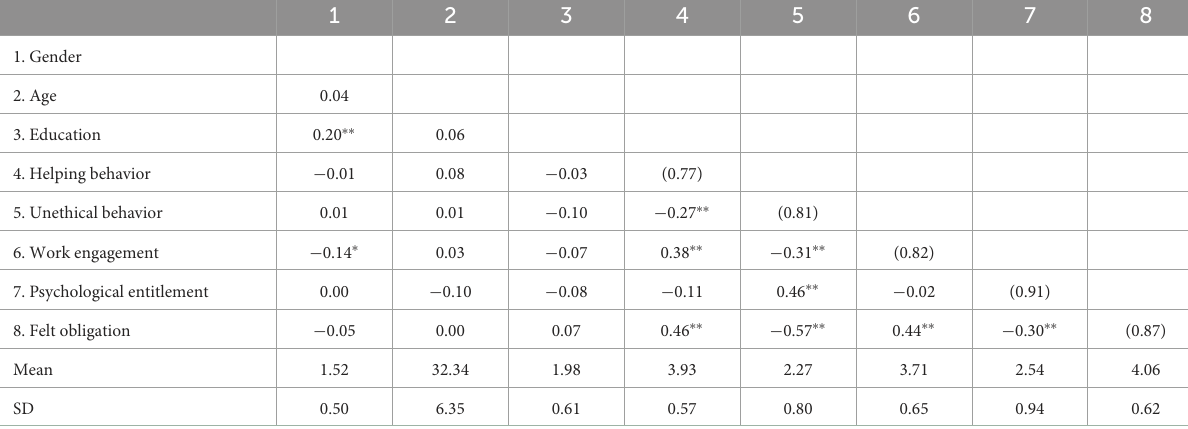
TABLE 2 Results of descriptive statistics and correlation